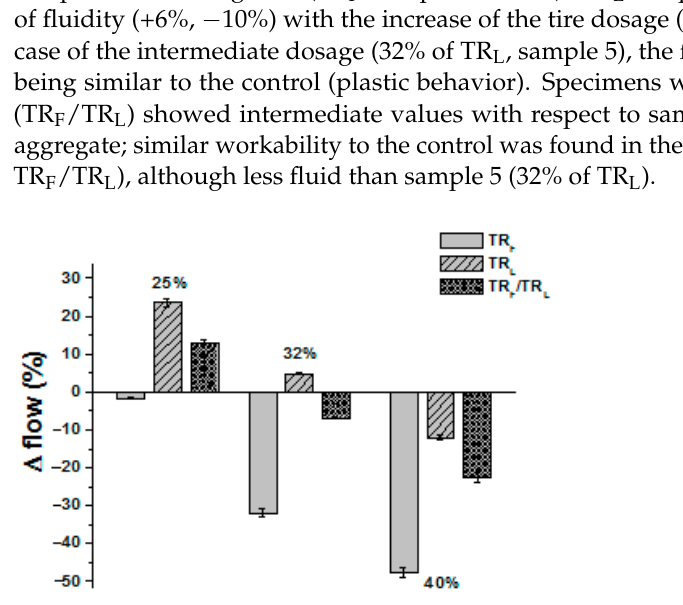
Figure 2. Flow test results of the TR samples with respect to the normalized mortar (control).